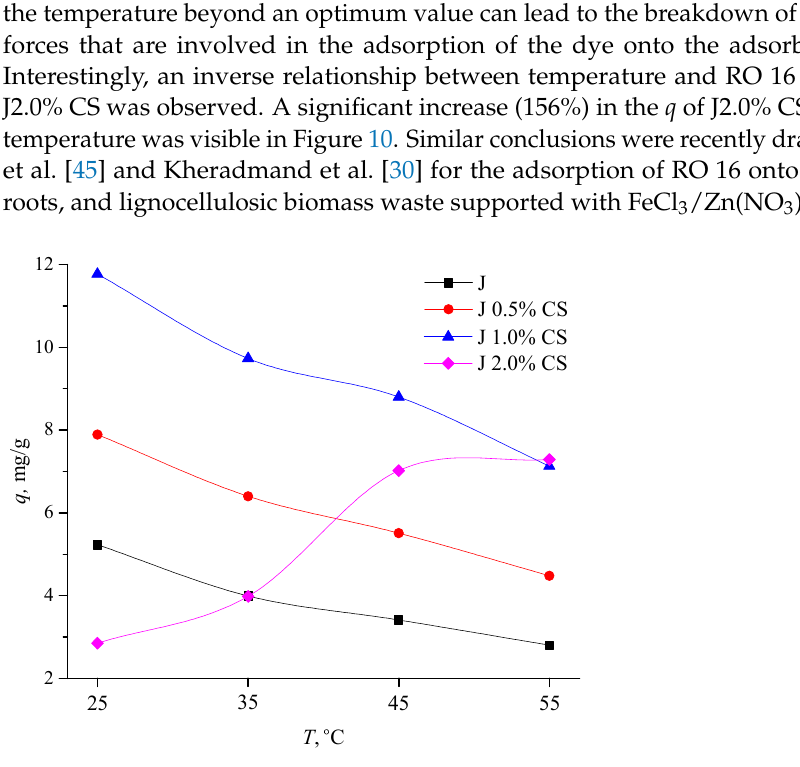
Figure 10. The influence of temperature ( T ) on the adsorption potential ( q ) of examined fabrics ( c 0 = 100 mg/L, t = 21 h, T = 25, 35, 45, or 55 °C, pH of 2.0 (for J, J0.5% CS, and J1.0% CS) and 4.0 (for J2.0% CS), the mass of adsorbent 0.25 g).